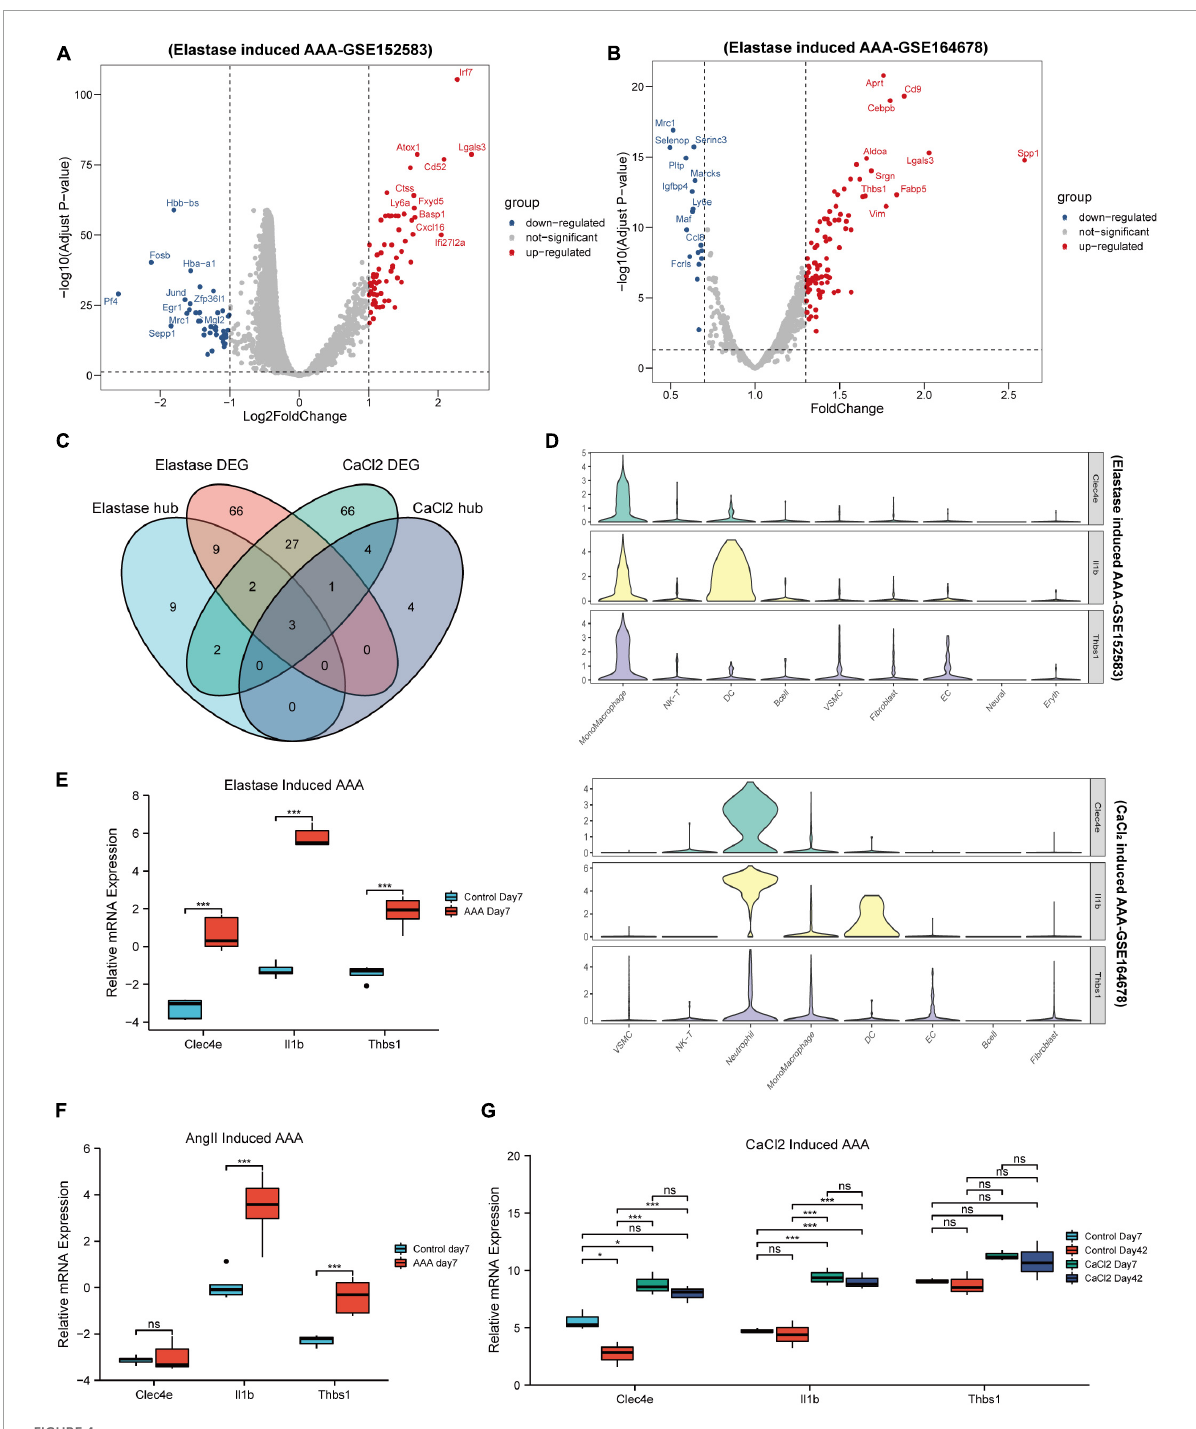
FIGURE4 Identification of key genes. Volcano map of differential genes for monocytes/macrophages populations between control and AAA model group in peri-adventitial elastase incubation induced AAA dataset (GSE152583) (A) and CaCl 2 induced AAA dataset (GSE164678) (B) . Veen diagrams of DEGs and hub genes for monocytes/macrophages populations between elastase induced AAA dataset and CaCl 2 induced AAA dataset (C) . Violin plots of Clec4e , Il1b , and Thbs1 expression in different cell types from peri-adventitial elastase incubation induced AAA dataset and CaCl 2 induced AAA dataset (D) . Boxplot showing the relative expression of Clec4e , Il1b , and Thbs1 in the early stage AAA and control aortas for intraluminal elastase perfusion induced AAA microarray dataset (GSE51227) (E) and AngII induced AAA dataset (GSE17091) (F) . Boxplot showing the relative expression of Clec4e , Il1b , and Thbs1 in AAA and control aortas of day 7 and 42 for CaCl 2 induced AAA microarray dataset (GSE109639) (G) . * P < 0.05, **** P <